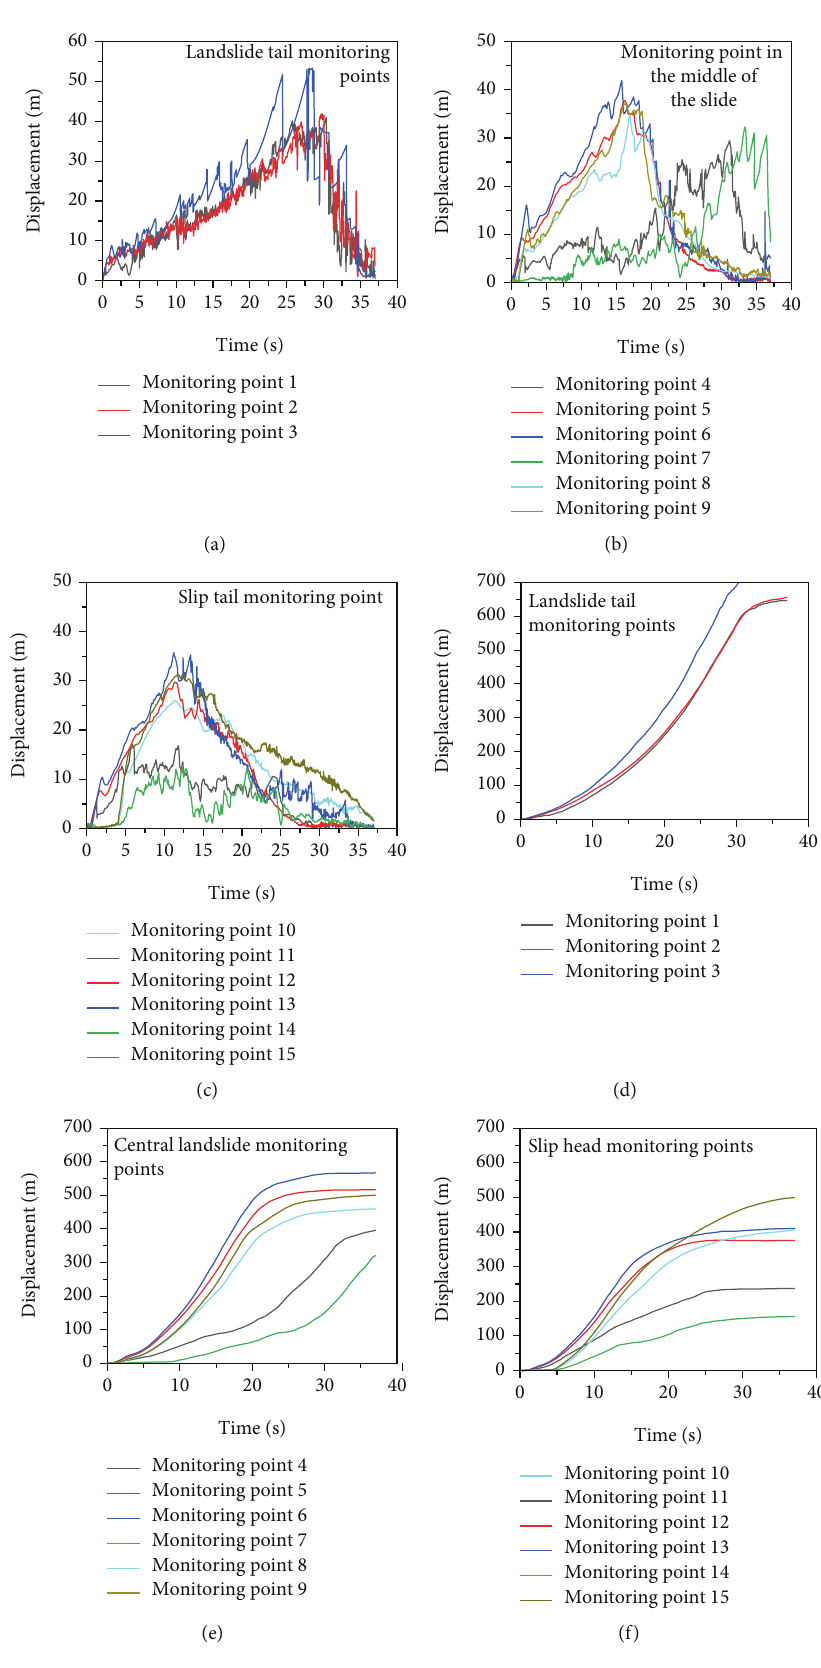
Figure 13: Comparison of velocity displacement at head, middle, and tail monitoring